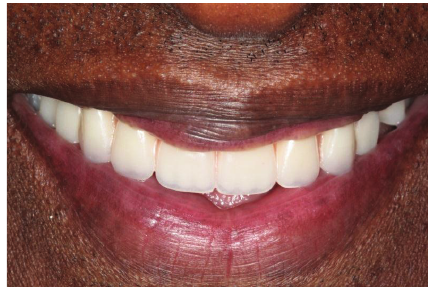
Figure 5: Intraoral frontal view with the epoxy resin